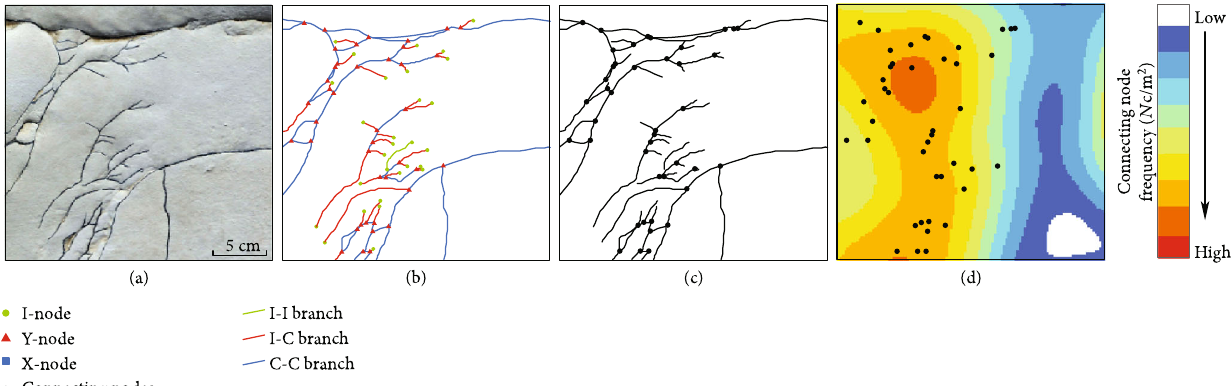
Figure 2: (a) Example of a fracture network from the fi eld at Ras ir Raheb, Malta. (b) Topological characterization of the example shown in (a), using topological nomenclature proposed by Sanderson and Nixon [44]. We di ff erentiate between di ff erent types of nodes and branches. Nodes are classi fi ed as isolated nodes (I-nodes), abutting or splaying nodes (Y-nodes), or as crossing nodes (X-nodes). Branches are classi fi ed as isolated (I-I), partly connected (I-C), or fully connected (C-C). (c) Network showing only the connecting nodes. (d) Illustration of the connecting node frequency (connecting nodes/m 2 ) of the fracture network.